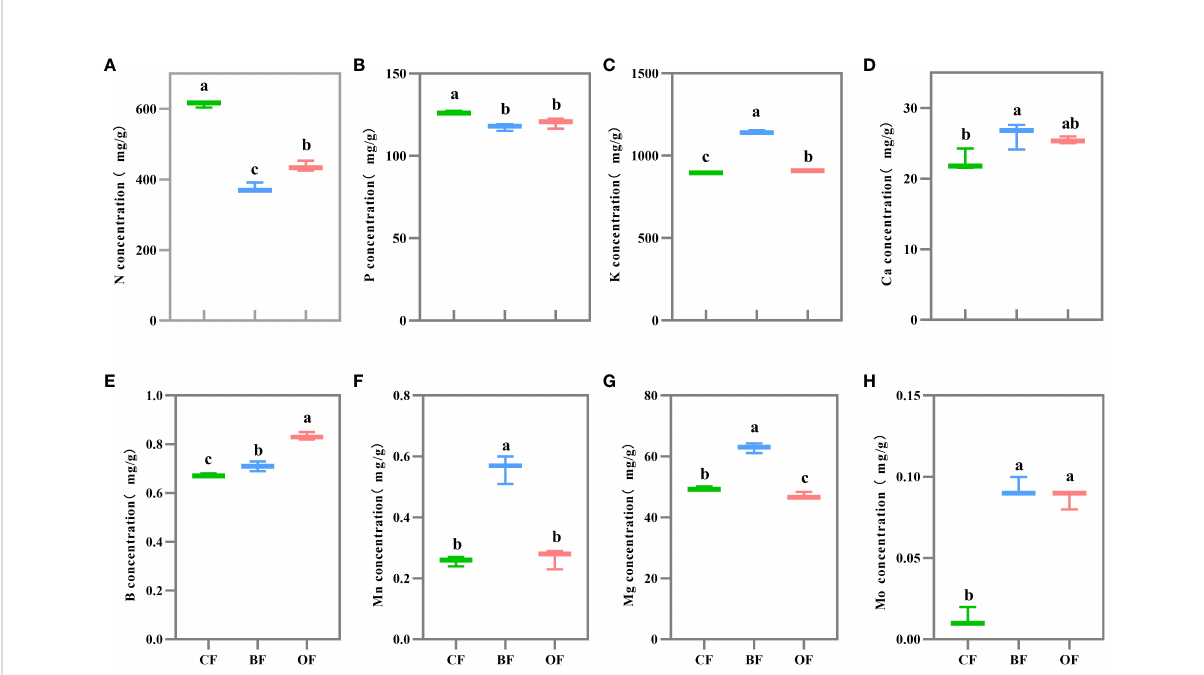
FIGURE 2 Effects of different fertilization treatments on the mineral contents of pear fruit. Values followed by different letters differ signi fi cantly (A – H) : Nitrogen concentration; Phosphorus concentration; Potassium concentration; Calcium concentration, Boron concentration; Manganese concentration; Magnesium concentration; Molybdenum concentration. (Duncan ’ s test, P< 0.05, n = 5 ). CF, OF and BF denote for chemical fertilizer, organic fertilizer and bio-organic